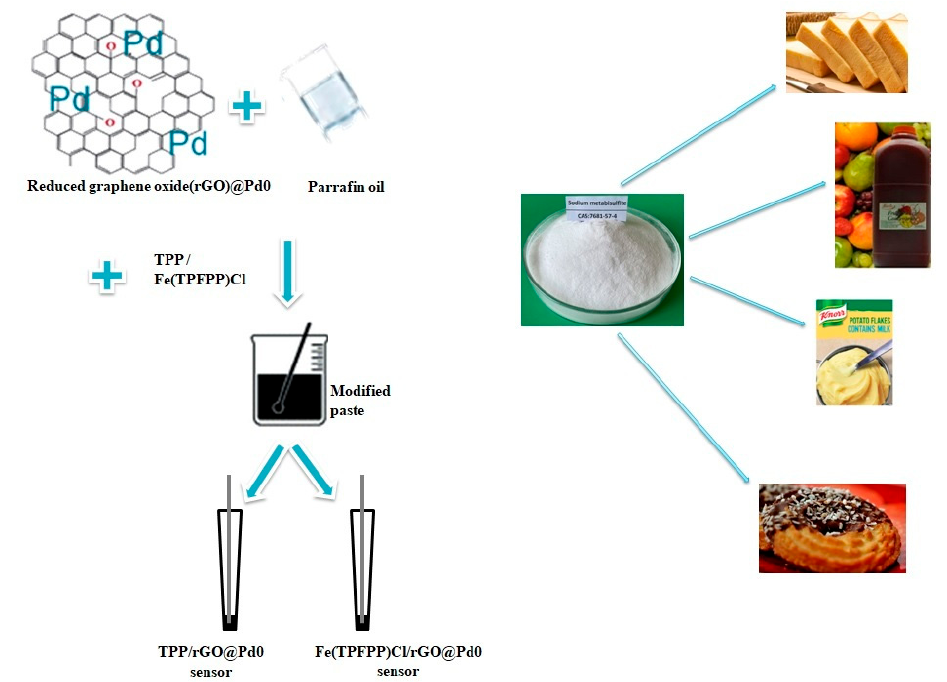
Scheme 1. Design of the modified electrochemical